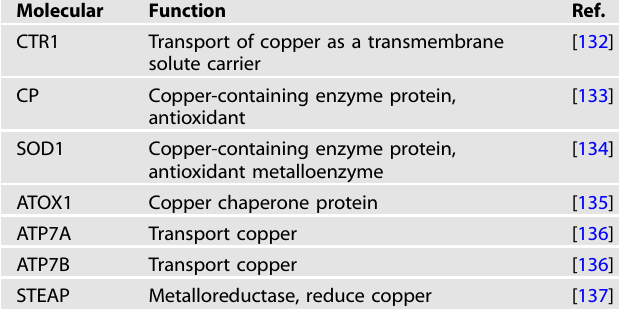
Table 1. Principal modulators of copper metabolism. Molecular Function